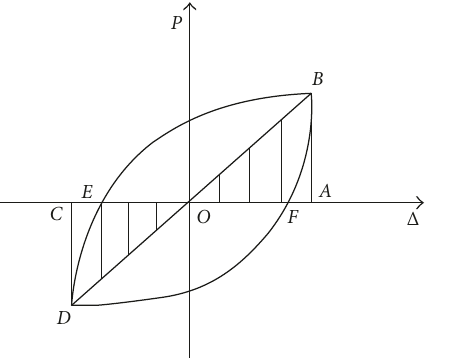
Figure 19: Idealized P - Δ hysteretic